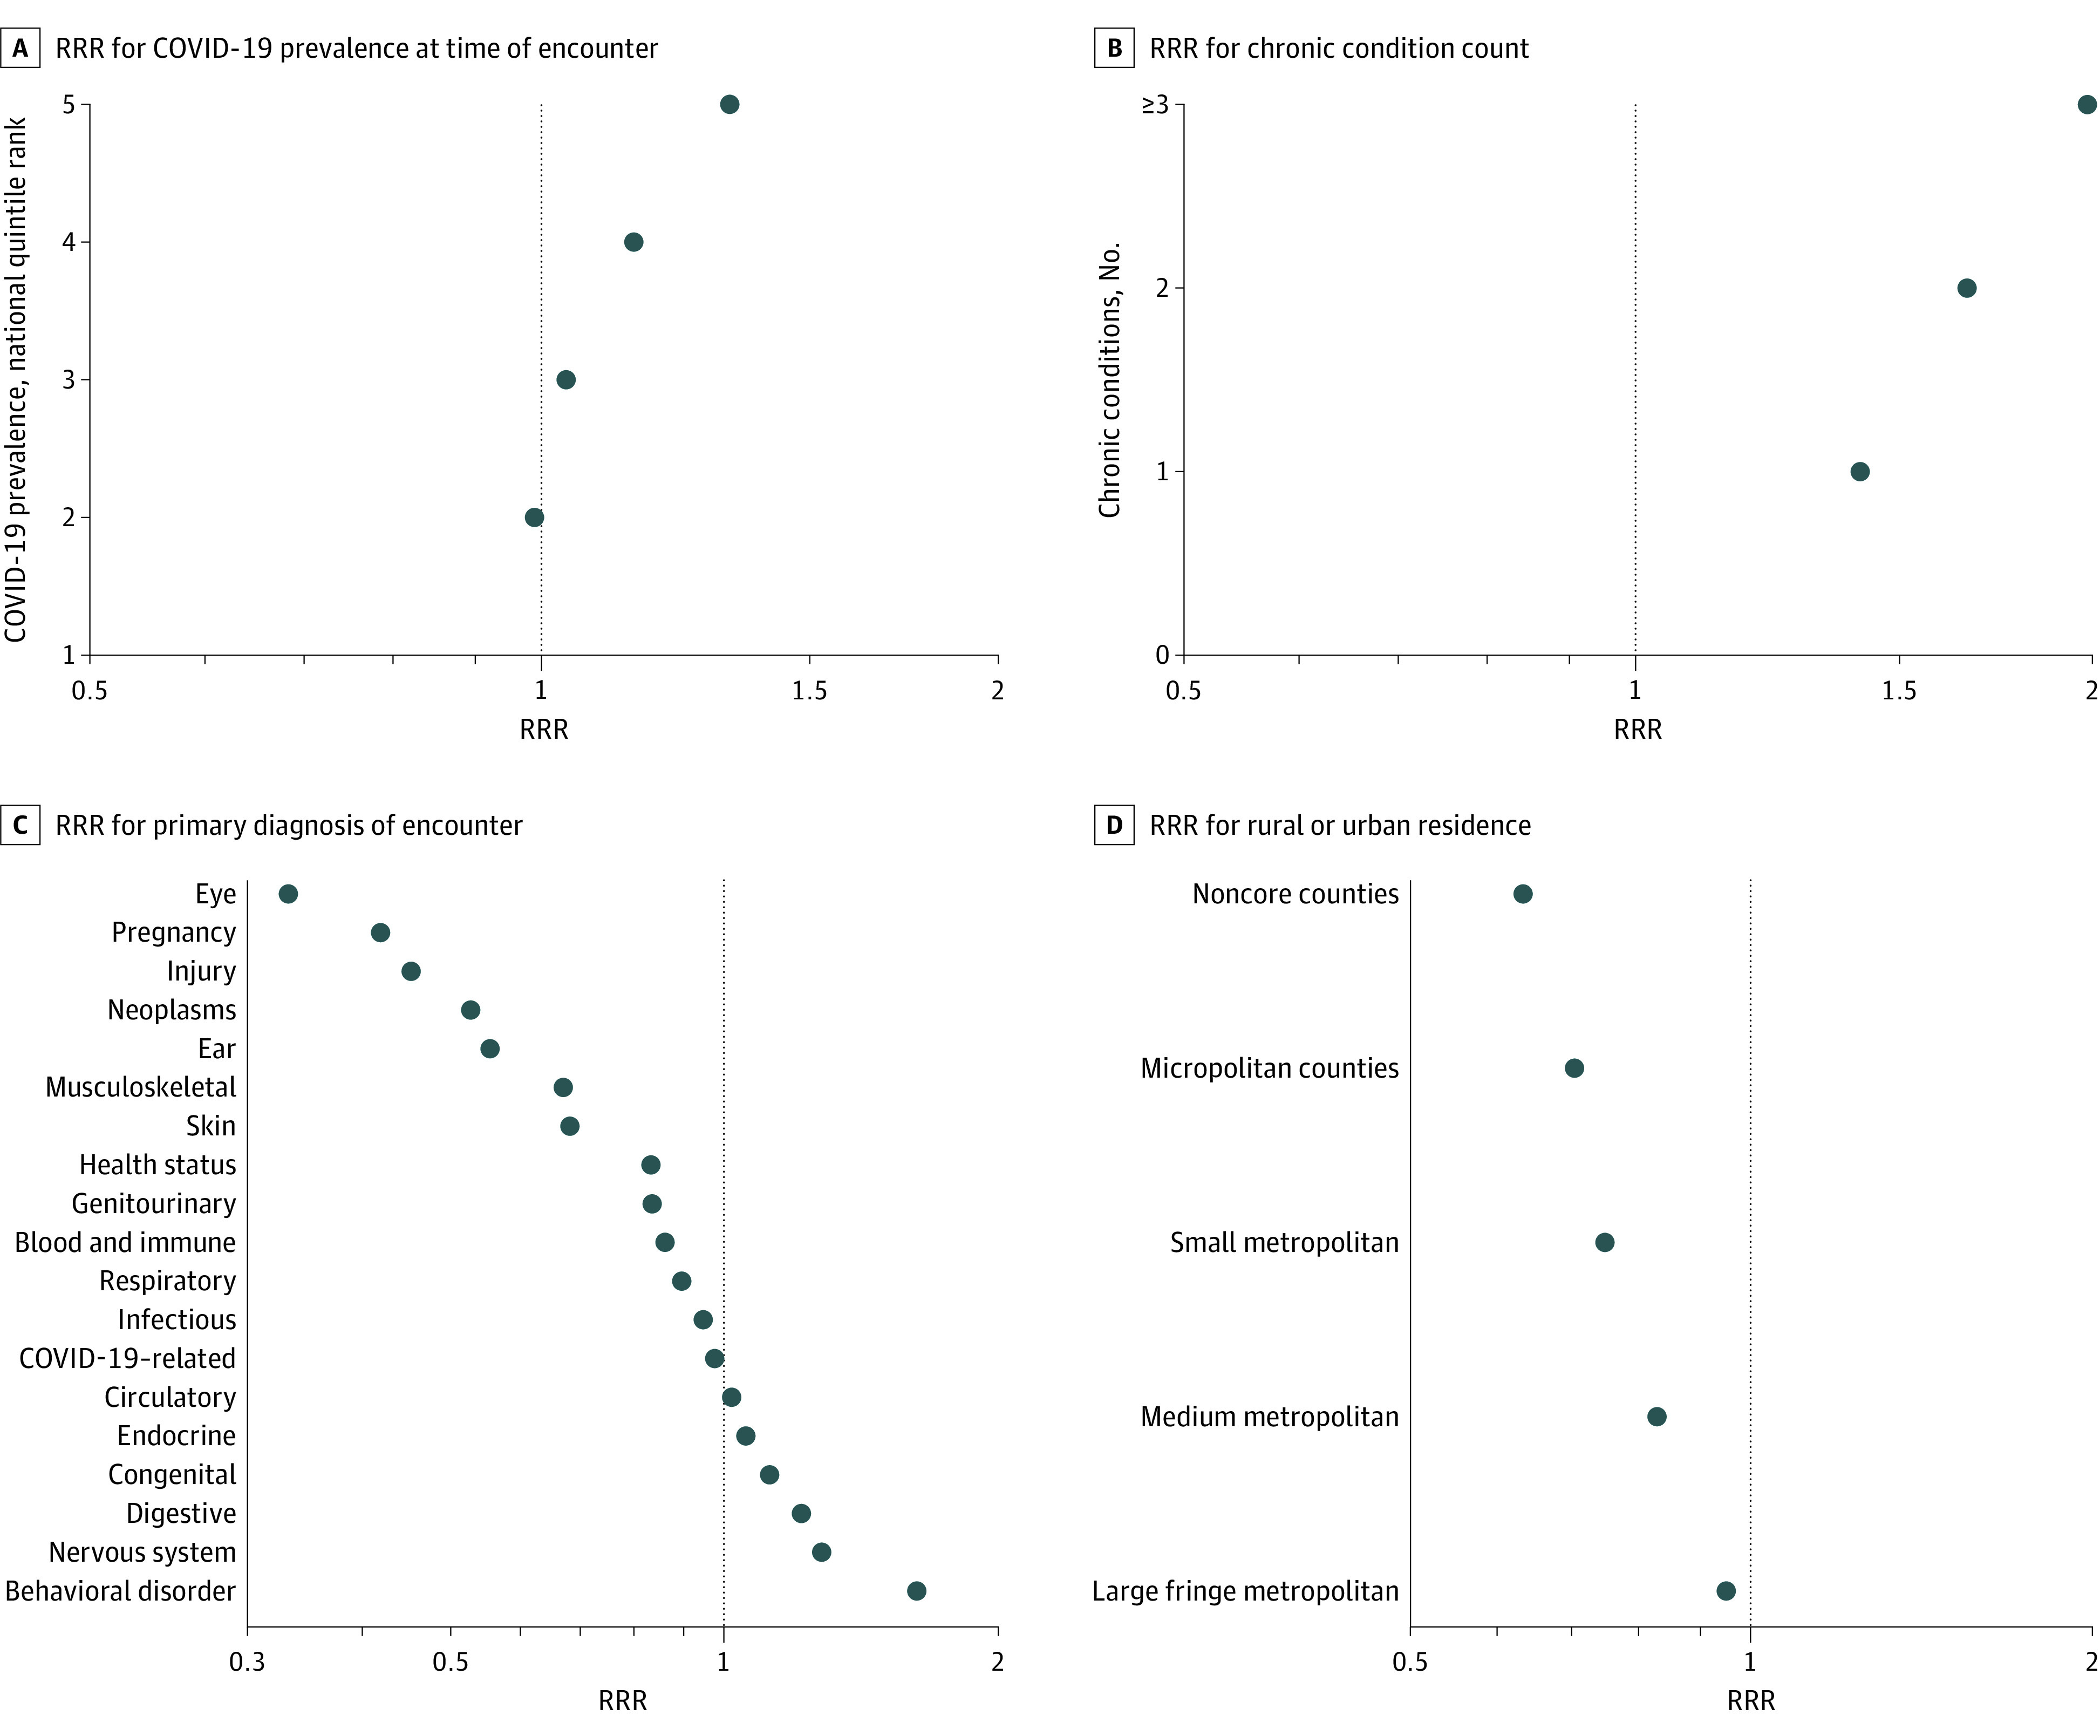
Adjusted Relative Risk Ratios (RRRs) Associated With Telehealth vs In-Person Ambulatory Visits During 2020 COVID-19 Study PeriodThe RRRs reflect the odds of a telehealth contact vs in-person visit. The sample included 15 427 217 persons in the continuously insured cohort with 1 or more telehealth eligible ambulatory visit during the 4-month March to June 2020 study period. These individuals had 46 453 007 in-scope encounters. All RRRs are adjusted for age, sex, plan type, chronic condition count, morbidity categories, region, urban vs rural residence, Area Deprivation Index, COVID-19 prevalence during week (for encounter) or hot spot (for person level), and type of service. For panel A, the reference is the first (lowest) quintile. For panel B, the reference is 0 chronic conditions. For panel C, the reference is International Statistical Classification of Diseases and Related Health Problems, Tenth Revision diagnosis chapter for signs and symptoms. For panel D, the reference is large central metropolitan area. The encounter-level analyses (panels A and B) are also adjusted for practitioner specialty and new patient and new condition combinations for that contact. RRR values are plotted on log scales. Every result shown here is statistically significant (P < .05) and does not overlap with an RRR of 1.0 because of the large sample size. See eFigure 4 in the Supplement for the numeric value of each RRR and 95% CIs, along with additional adjusted RRR analysis results for other key variables.